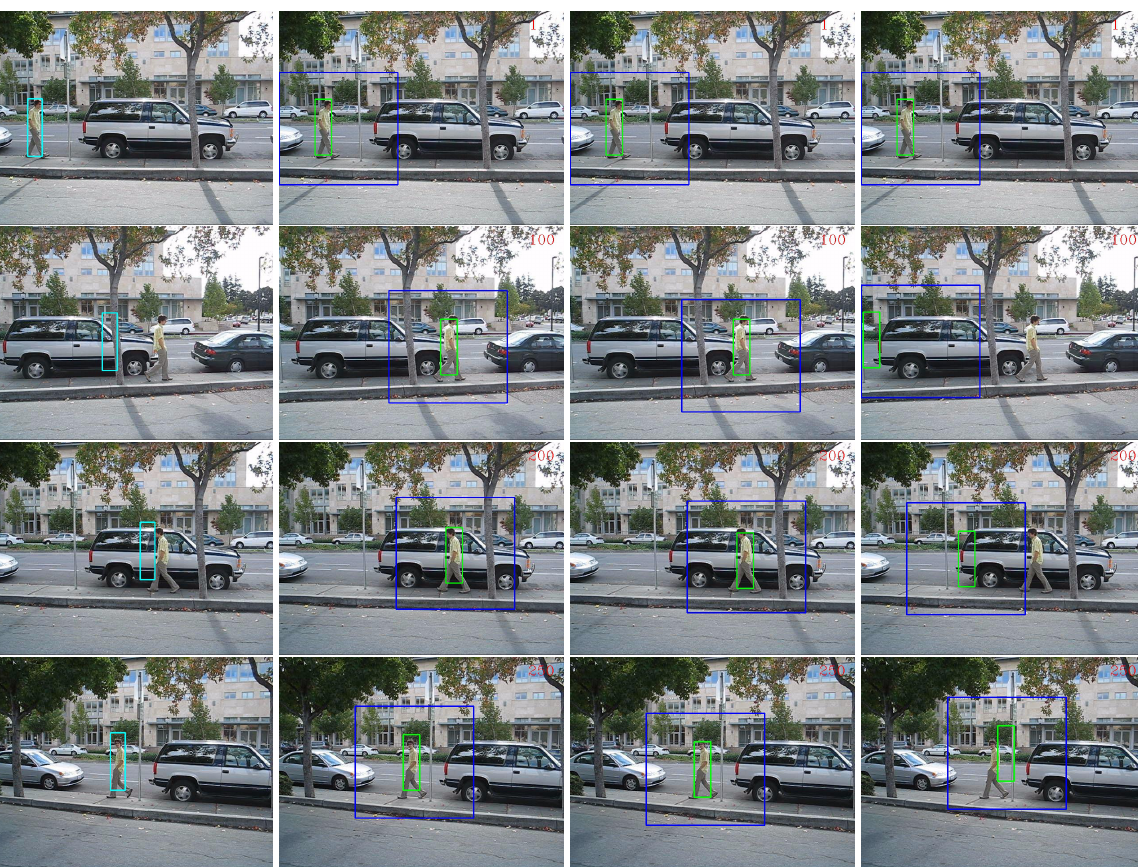
Tracking results on the “David-outdoor” sequence using different updating policies. Column 1: “MILTracker”. Column 2: “AdpCov+cu”. Column 3: “AdpCov+nu”. Column 4: “AdpCov+fu”. In the last three columns, the blue rectangles indicate the search windows and the green rectangles show the tracking results. Row 1: Frame #1. Row 2: Frame #100. Row 3: Frame #200. Row 4: Frame